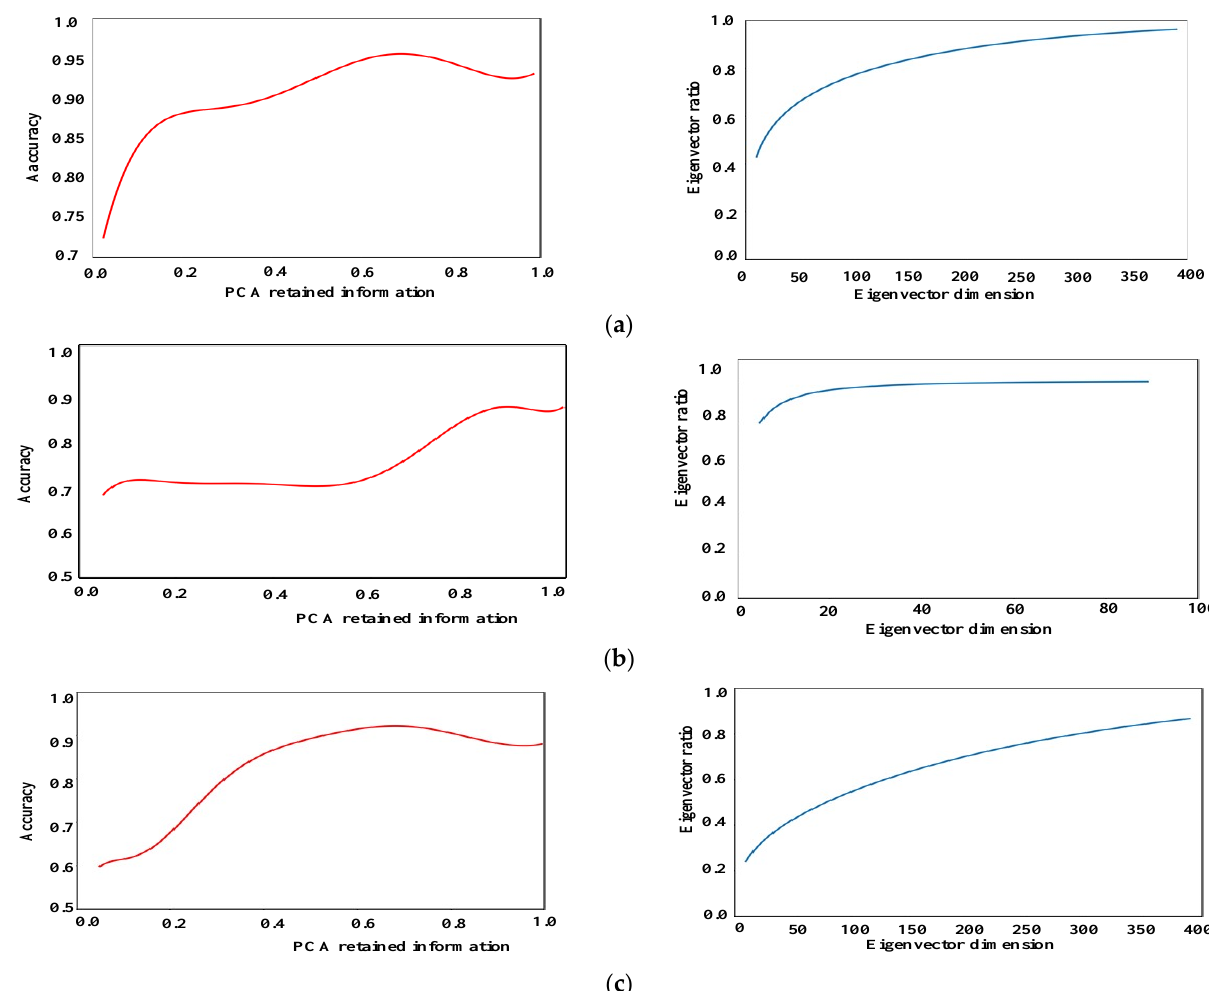
Figure 8. Characteristic dimension analysis. ( a ) Retained information and eigenvector analysis of HOG after PCA, ( b ) retained information and eigenvector analysis of Harr after PCA, ( c ) retained information and eigenvector analysis of local binary pattern (LBP) after principal component analysis (PCA).